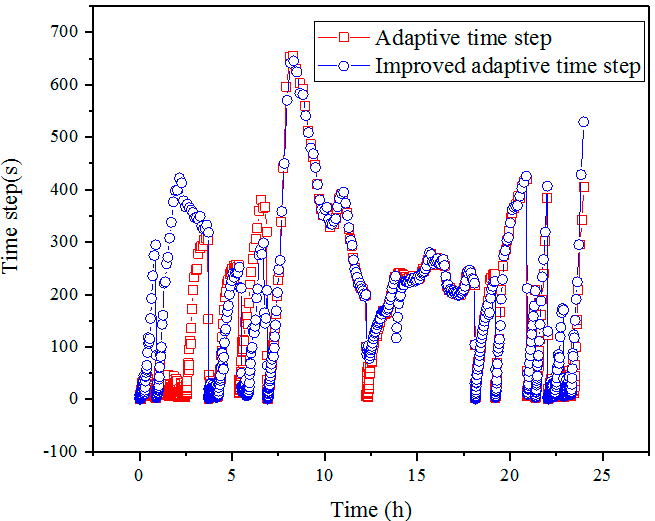
Figure 8. The time step versus